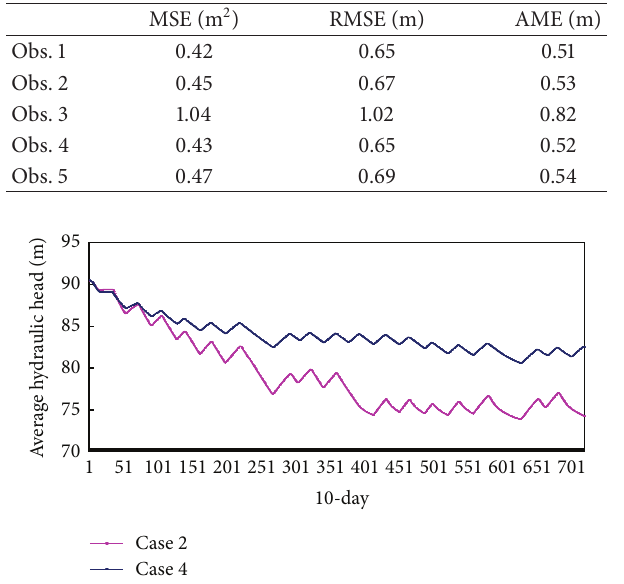
Figure 9: Comparison of average hydraulic heads in Case 2 and 4.